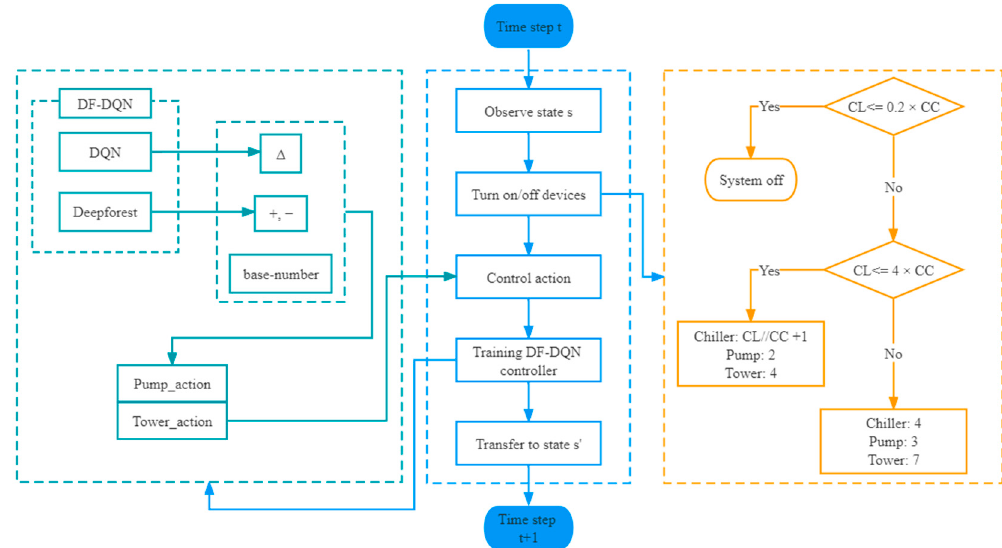
Figure A1. The workflow of system.